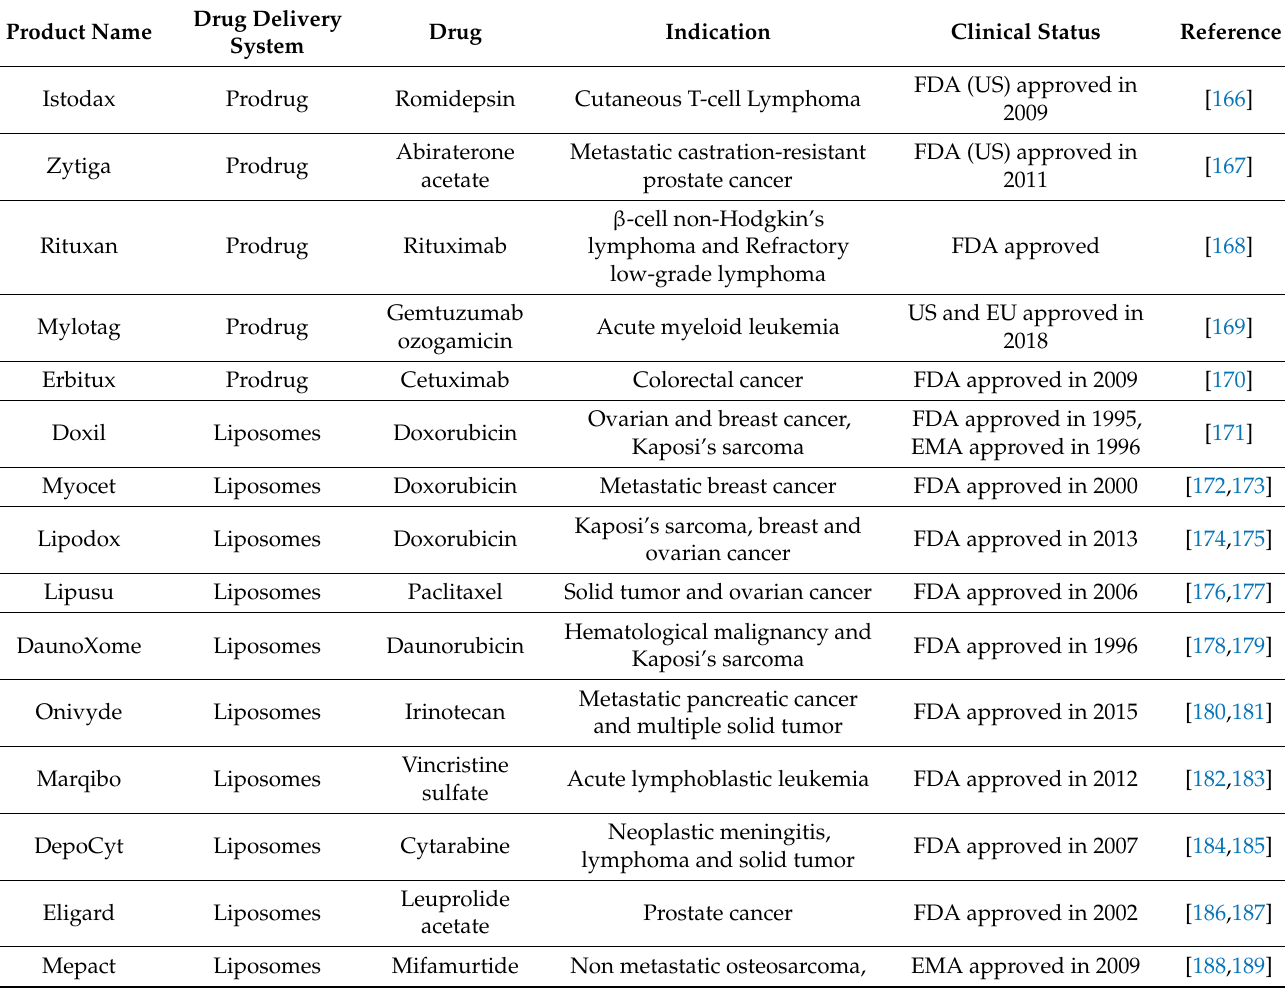
Table 4. List of FDA-Approved Prodrugs and Liposomes for Anticancer